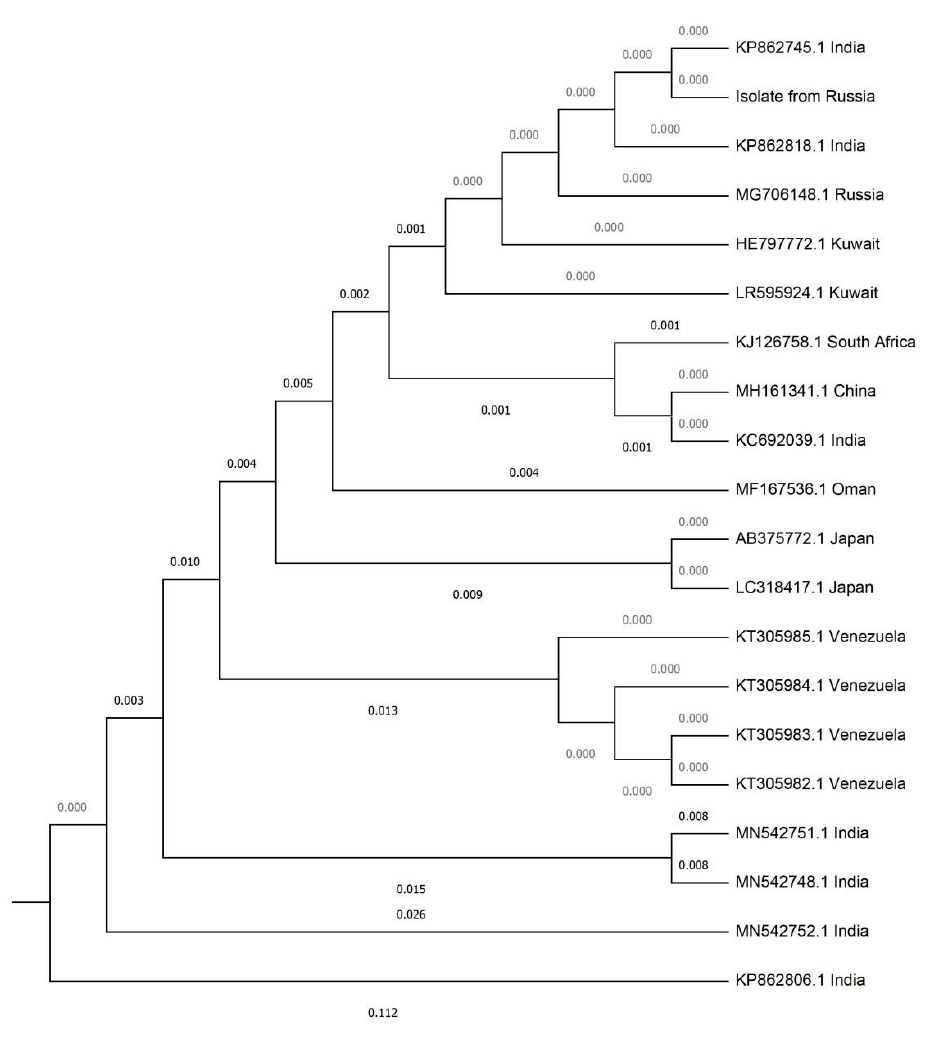
Figure 1. Phylogenetic tree of ITS region.